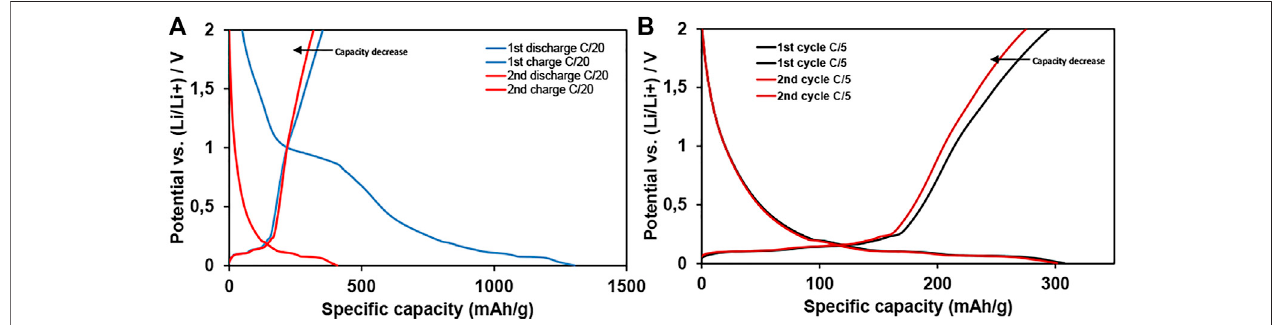
FIGURE 7 | First and second charge – discharge curves for the 50 wt% graphene NP3 electrode at (A) C/20 and (B) C/5 current rates. The total active material is 94.5 wt%.